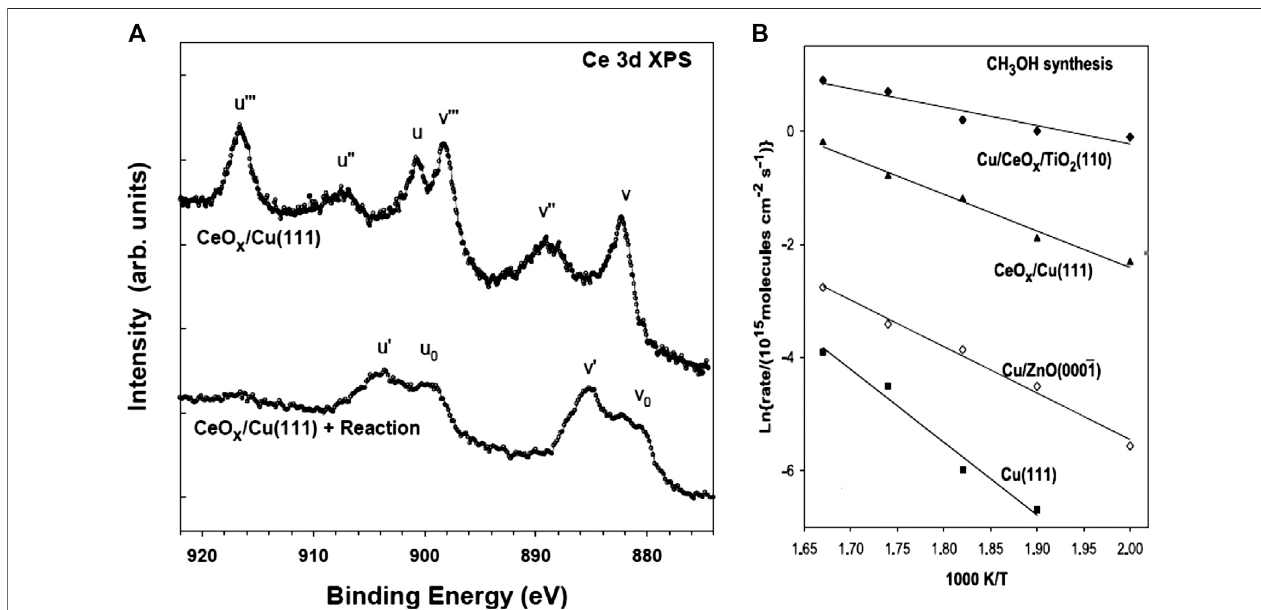
FIGURE12|(A) Ce3dXPSspectracollectedbeforeandafterperformingthehydrogenationofCO 2 onaCeO x /Cu(111)surface.Reactionconditions:catalystwas exposedto0.5 atmofCO 2 and 4.5 atmofH 2 ,at 500 K,for15 min. (B) Arrheniusplot formethanol synthesis on Cu(111); Cu/ZnO ( 0001 ) ,0.2 ML ofCu;CeO x /Cu(111), Cu(111) surface covered 20% by ceria; and Cu/CeO x /TiO 2 (110), 0.1 ML of Cu on a TiO 2 (110) surface pre-covered 15% with ceria. Reaction conditions: catalysts were exposed to 0.5 atm of CO 2 and 4.5 atm of H 2 (Graciani et al., 2014). Reproduced with permission from American Association for the Advancement of Science.